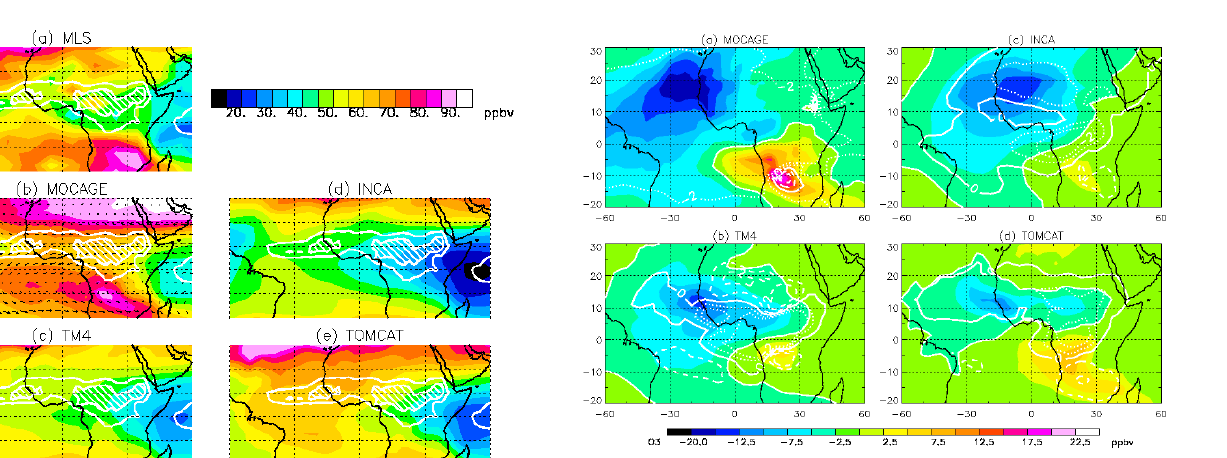
Fig. 8. August 2006 O 3 distribution at 215hPa (a) Aura/MLS ob- servations and simulations by (b) MOCAGE (c) TM4 (d) INCA and (e) p-TOMCAT. White contours indicate deep convection (OLR contours 240 and 215W/m 2 , with values below 215 hatched white).